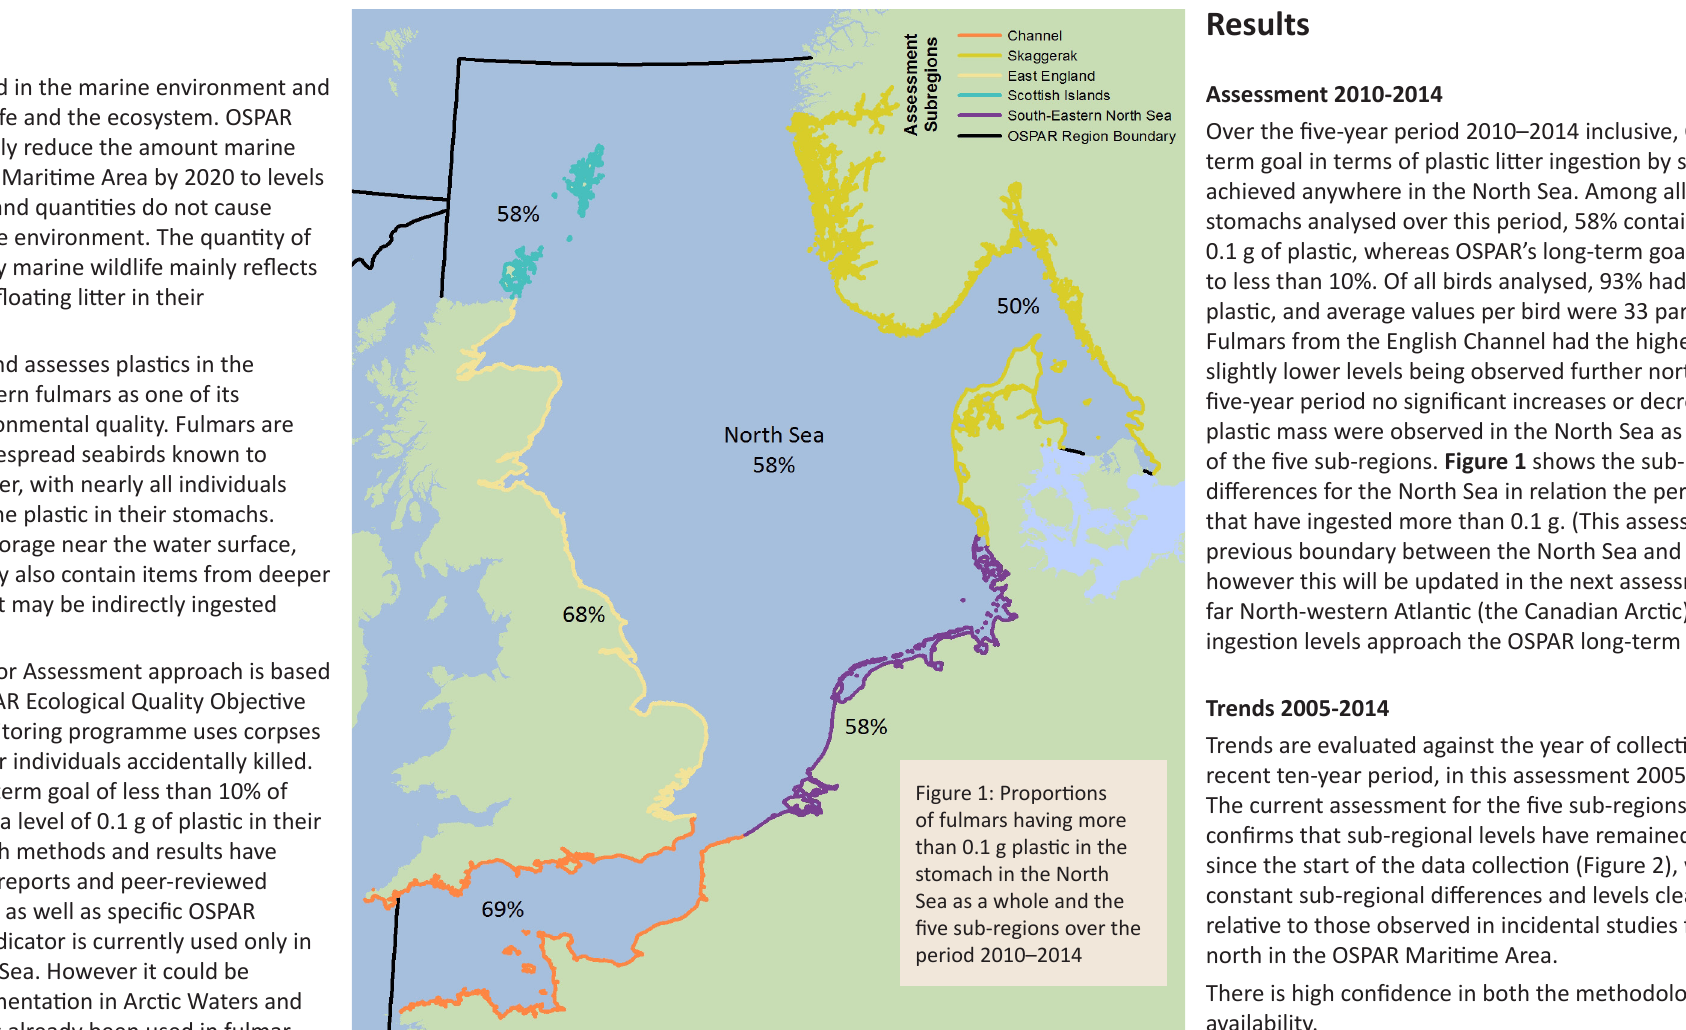
Figure 1: Proportions of fulmars having more than 0.1 g plastic in the stomach in the North Sea as a whole and the five sub-regions over